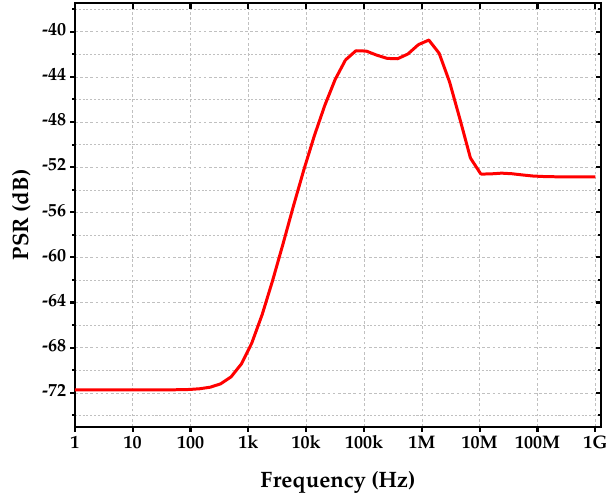
Figure 13. PSR of Proposed Reference Circuit.